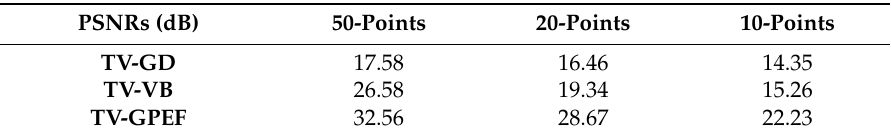
Table 1. Peak signal-to-noise rations (PSNRs) (dB) of the straight-line scanning from the Sheep-Logan phantom.